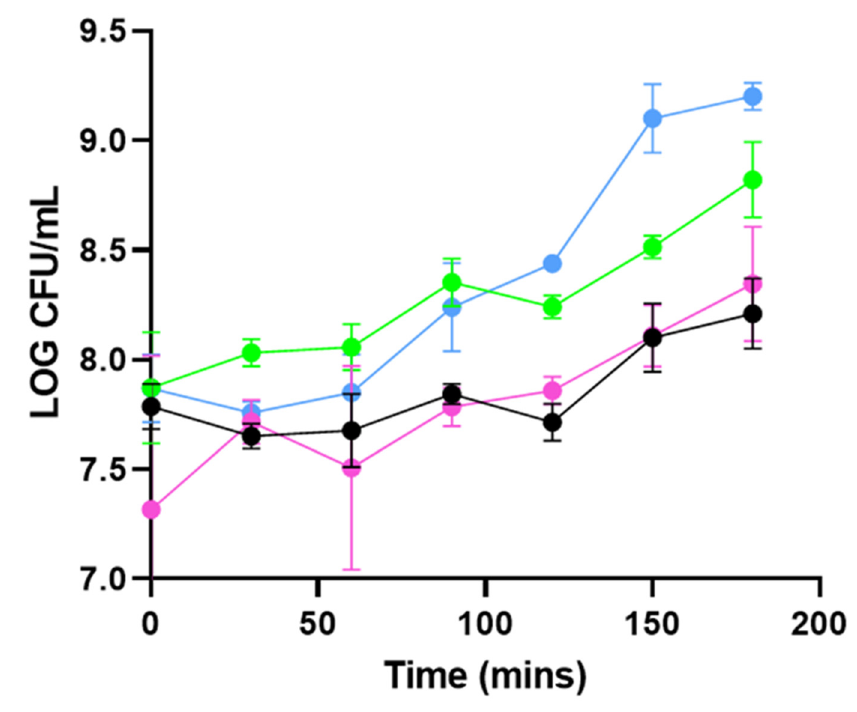
Figure 2. Experiment 1B: growth inhibition assays at 37 ◦ C using 1 × 10 7 CFU/mL L. monocytogenes 473 (serotype 4e). L. monocytogenes strain 473 was inoculated into TSB containing PHA_lysin293_BNPs (pink symbols) ( n = 4), PHA_amidase293_BNPs (black symbols) ( n = 4), L. mono + PHA_BNP control (green symbols) ( n = 4), and L. mono-PHA_BNPs (blue symbols) ( n = 4). Cells were incubated at 37 ◦ C and samples taken for plating on Listeria Chromogenic Agar at 0, 30, 60, 90, 120, 150 and 180 min. The figure depicts total counts of L. monocytogenes.